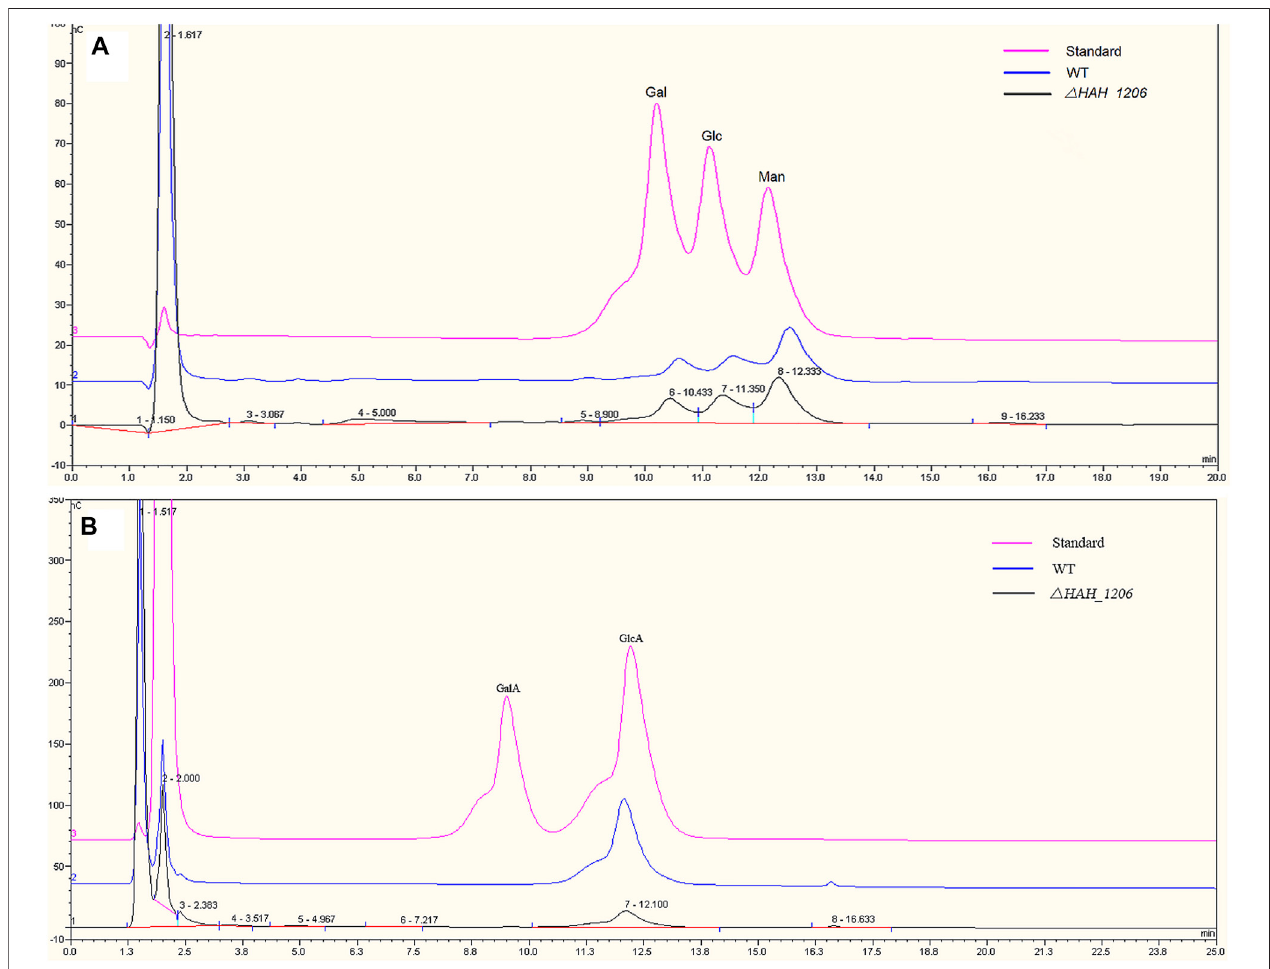
FIGURE5| Comparative analysisofmonosaccharides inEPSs from H.hispanica and △ HAH_1206 withHPAEC-PAD. (A) Analysisofneutral monosaccharides of EPSs. The chromatomap in pink is the standard mixture of galactose(Gal), glucose (Glc), and mannose (Man) at 2 mM, whereas the one in blue refers to the hydrolyzed product of EPSs from H. hispanica and the black one is the hydrolyzed product of EPSs from △ HAH_1206 . (B) Analysis of acidic monosaccharides of EPSs. The chromatomap in pink is the standard mixture of D-galacturonic acid (GalA) and D-glucuronicacid (GlcA) at 2 mM, whereas the blue one represents the hydrolyzed product of EPSs from H . hispanica , and the black one is the hydrolyzed product of EPSs from △ HAH_1206 .